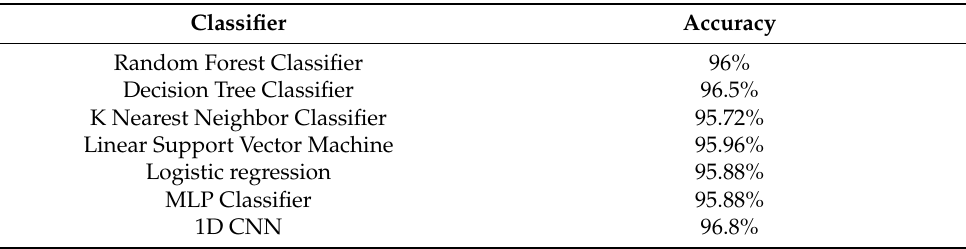
Table 3. Performance of the binary classification (normal/abnormal) of the data by various ML